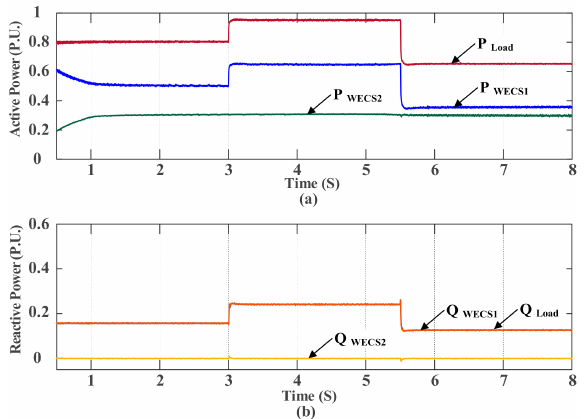
Figure 9. Balanced load change during autonomous mode: ( a ) Active power posture; ( b ) Reactive power posture.